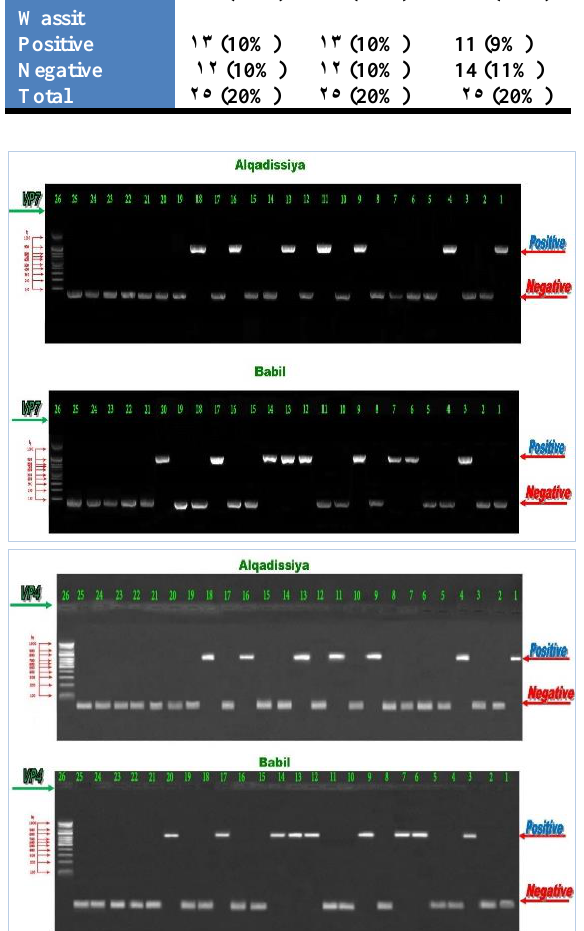
Figure, 1: The results have been obtained by using PCR method for Rotavirus in 125 fecal samples, which detected VP4 and VP7 (the figure show in two governates Al- qadissiya and